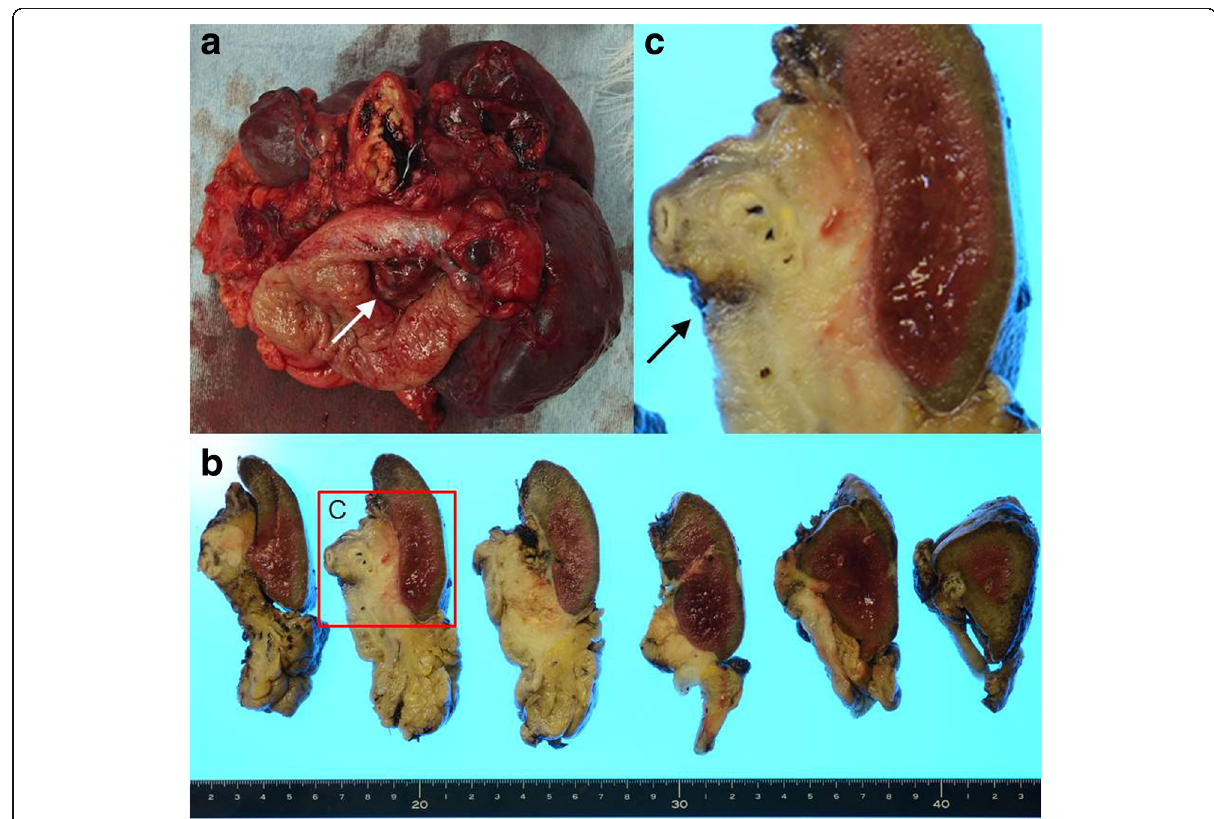
Fig. 6 Macroscopic findings of the excised specimen. a A mass was exposed in the lumen of the stomach (white arrow). b , c The splenic hilar lesion was enlarged to compress the surroundings, penetrating the stomach (black